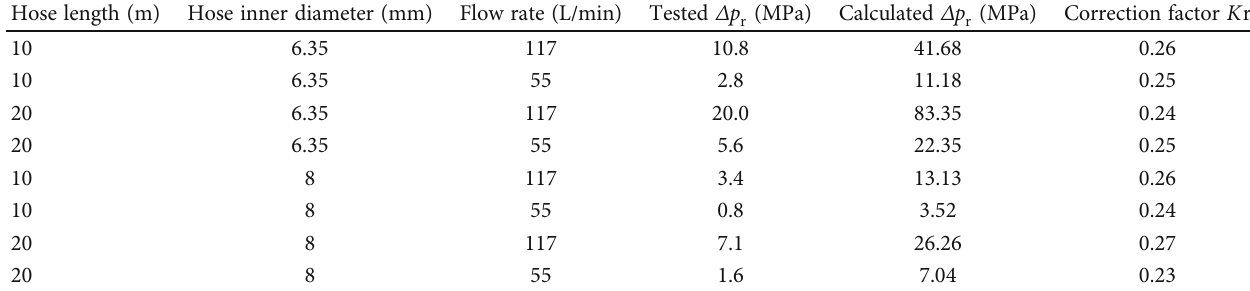
Table 1: Test data of the high-pressure hoses.